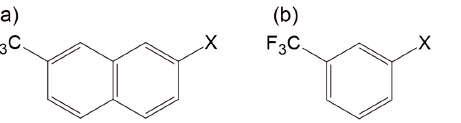
Figure 3. Similarity of 7 ‐ trifluoromethyl ‐ 2 ‐ X ‐ naphthalene 2 ‐ 7 ( a ) and m ‐ trifluoromethyl ‐ X ‐ benzene X ‐ ( m ‐ Ph) ‐ CF 3 ( b ).